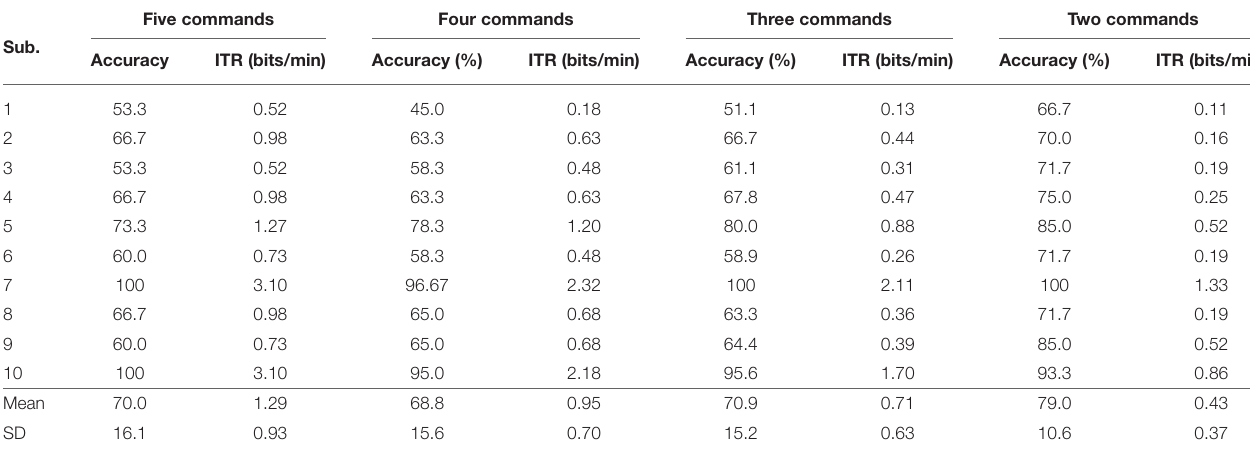
TABLE 1 | Summary of the detection performances in the offline analysis.